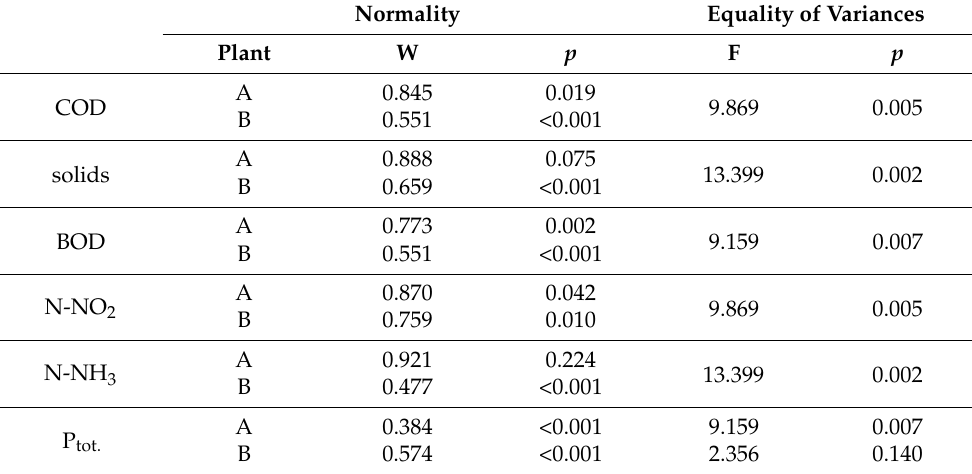
Table 7. Assumptions checks for independent sample T -test results of technological sewage com- pounds determinations—test of normality (Shapiro–Wilk test) and test of equality of variances (Levene test).